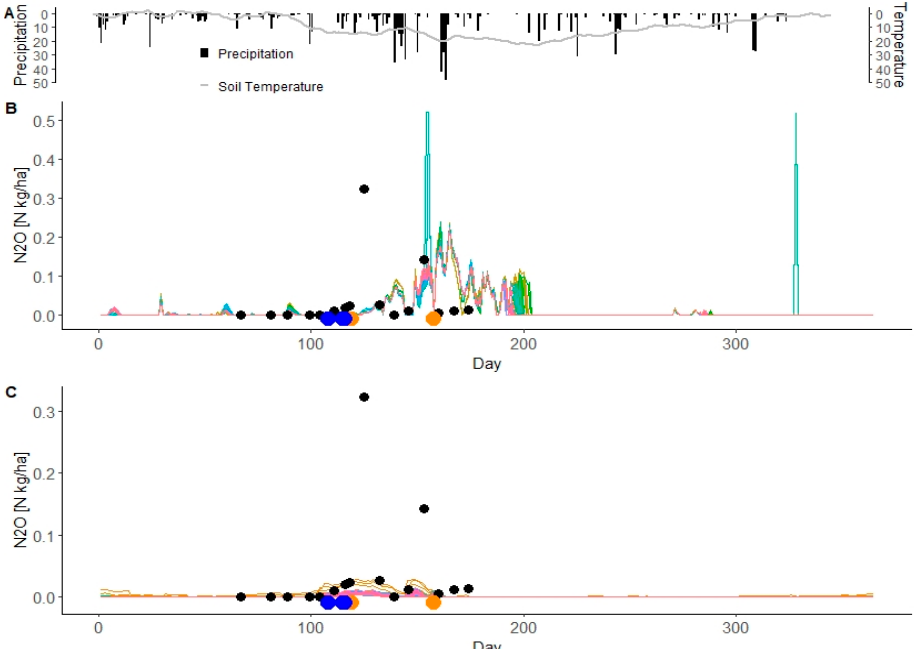
Figure 7. Simulated N 2 O emissions from grain corn in the Melk catchment at the HRU level (color lines) and measured N 2 O emissions (black points) from grain corn in Pötting in 2013 ( A ). ( B , C ) are M1 setup and M2 setup, respectively. Blue points indicate the dates of N fertilizer application in Pötting and orange points show the N fertilization in the SWAT simulations. The low spring N 2 O emissions from grain corn in the M1 and M2 setups in the first 120 days of the year are covered well, but the peak of N 2 O emissions after fertilizer appli- cation (real and simulated) are not captured by SWAT. During the remainder of the year for the M1 setup, the simulated N 2 O emissions from most grain corn HRUs show more peaks and are higher than the measured N 2 O emissions. For the M2 setup, the two main peaks of N 2 O emissions from grain corn were not captured by SWAT (Figure 7). The trends and timing for the low values were captured. Overall, the M2 setup had lower fluxes than the M1 setup (Figure 7).